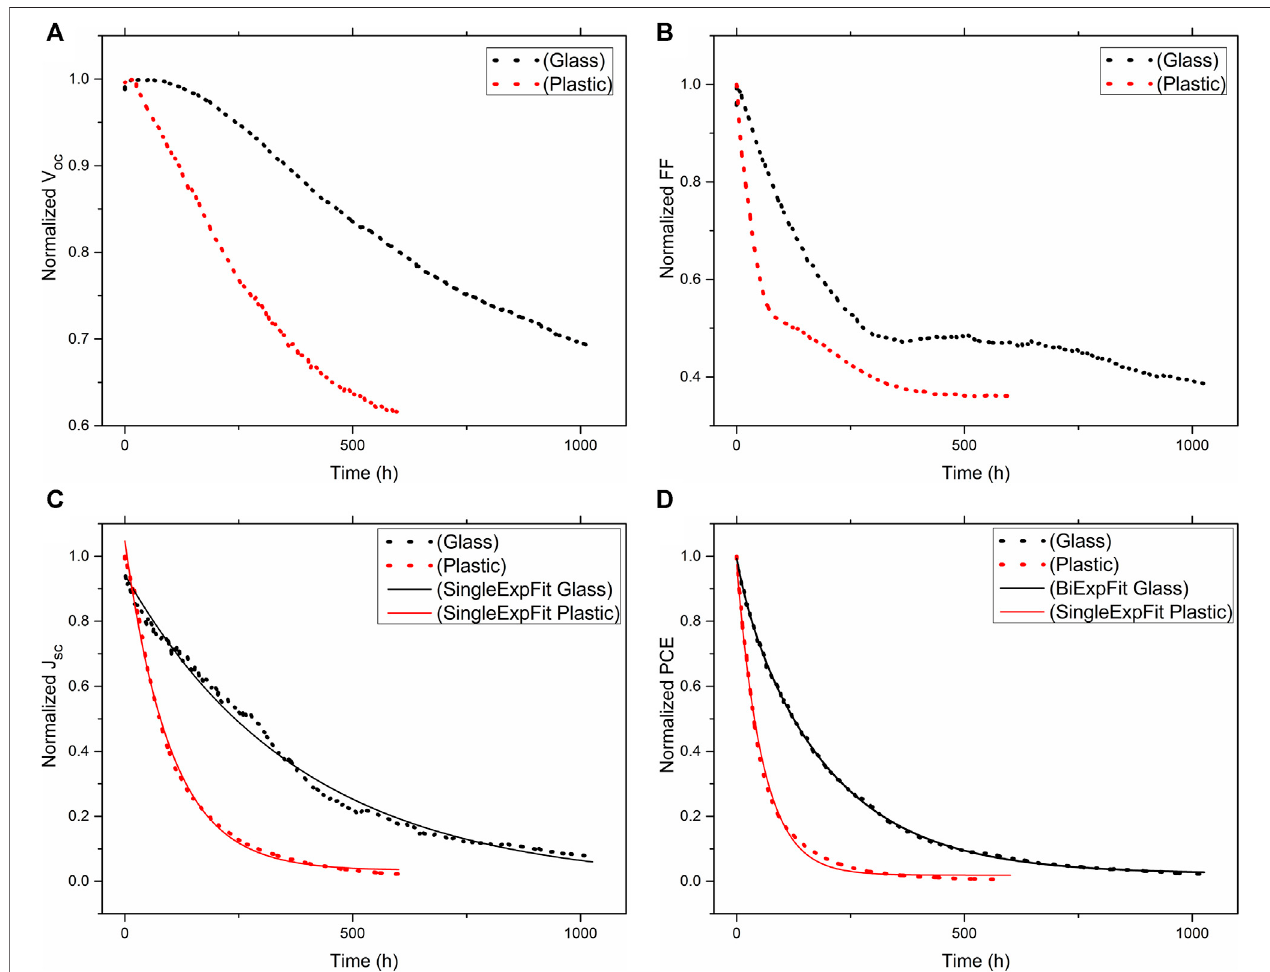
FIGURE 5 | Evolution of the OSC electrical parameters (Voc (A) , FF (B) , Jsc (C) and PCE (D) ) vs. time (glass and plastic encapsulation) for the continuous illumination ISOS L-1 test.